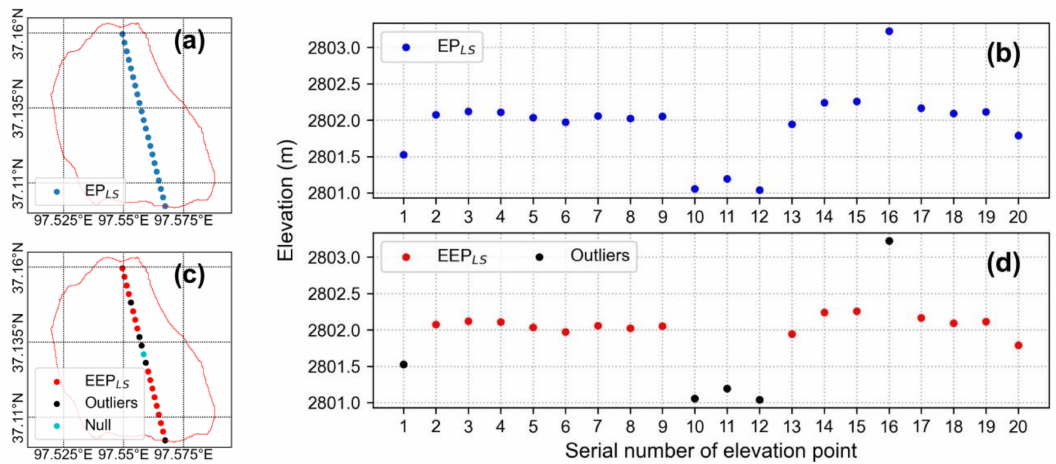
Figure 3. The ( a ) horizontal and ( b ) vertical distribution of the elevation points of the lake surface (EP LS ); and the ( c ) hori- zontal and ( d ) vertical distribution of the effective elevation point (EEP LS ) and